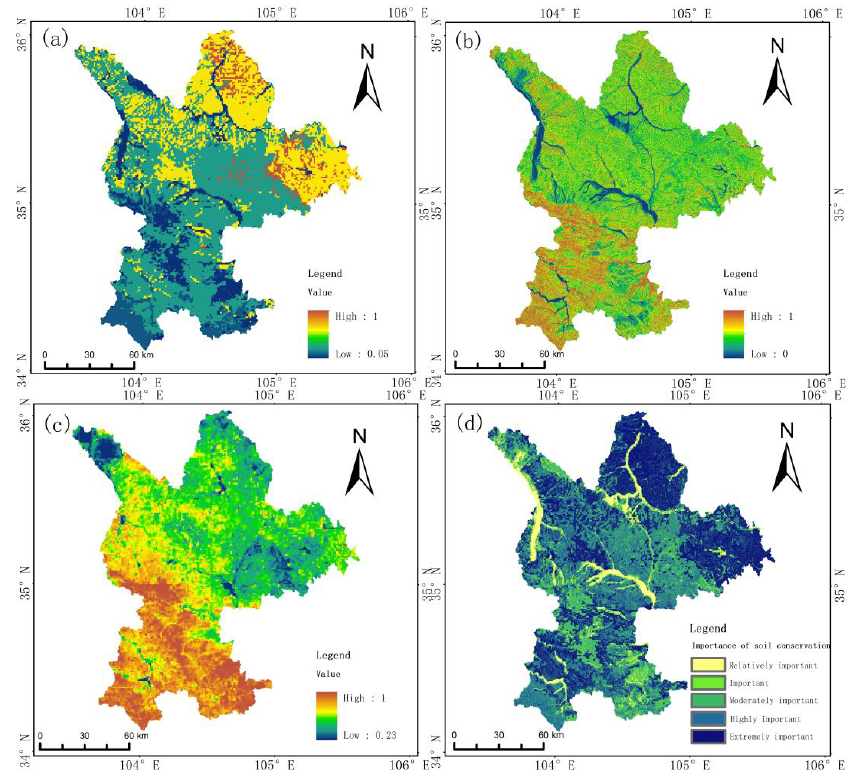
Figure 3. ( a ) Erosion intensity factor; ( b )topography factor; ( c ) vegetation factor; and ( d ) classifica- tion of soil conservation